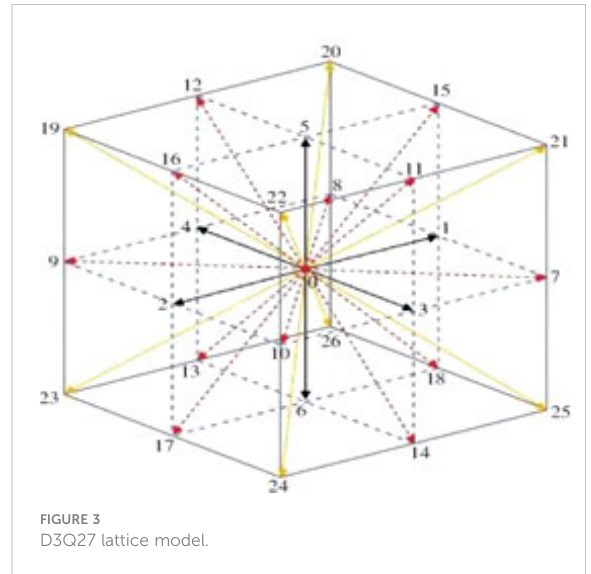
FIGURE 3 D3Q27 lattice